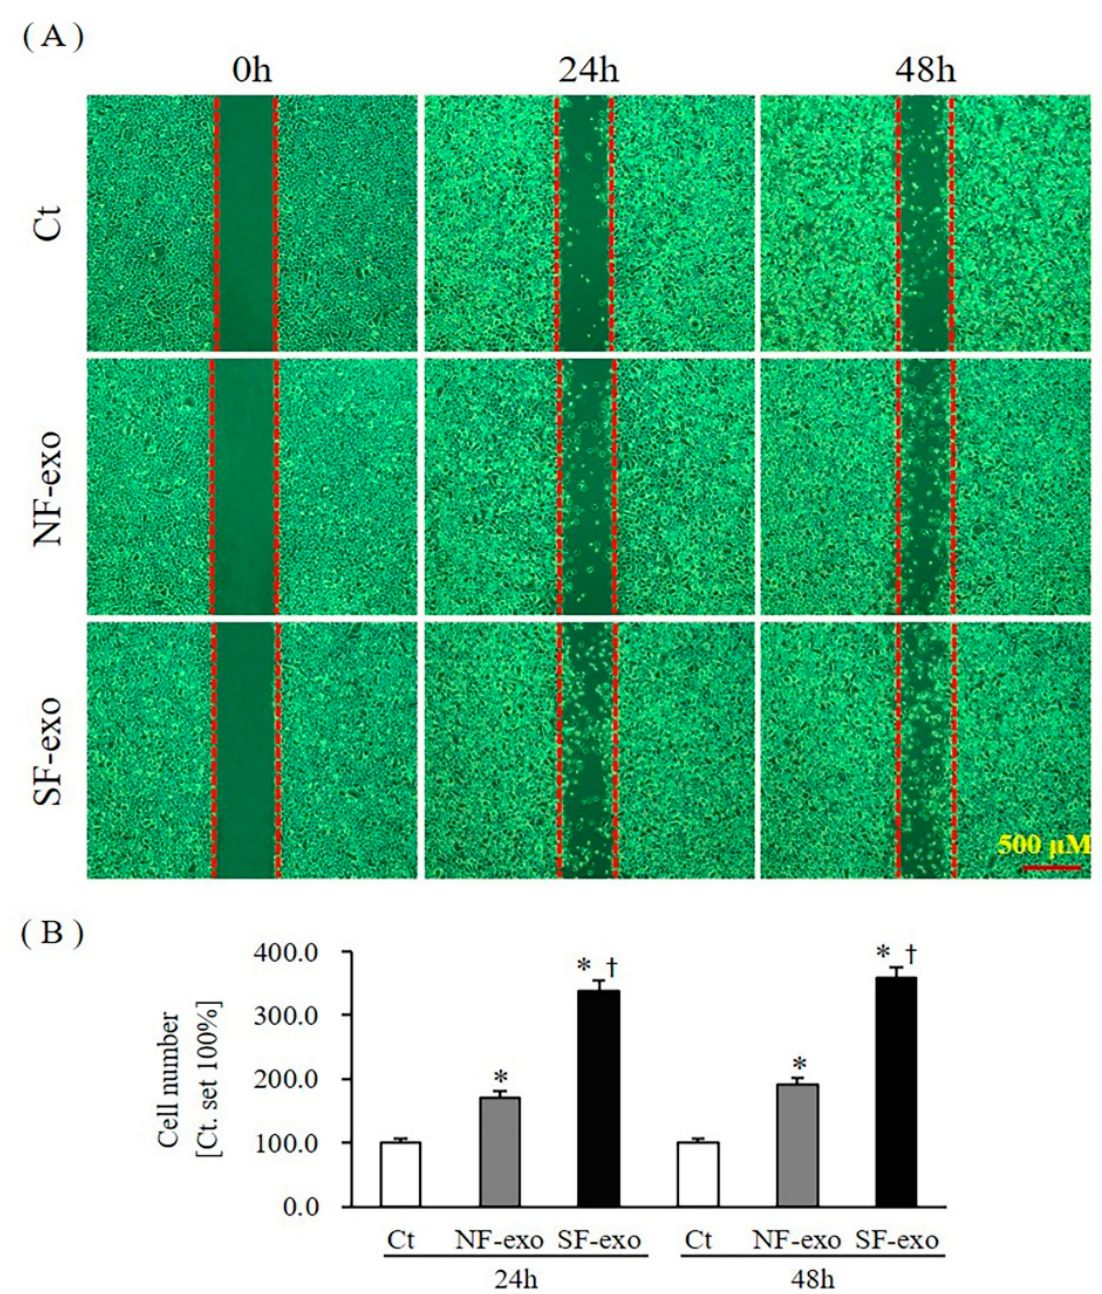
Figure 9. HTSF-exosome treatment dominantly increased the migration of NHKs. NHKs were treated with 100 µg/mL of NF- or HTSF-exosomes, and the control cells were treated with DPBS. After 24 and 48 h, migration of the cells was photographed (scale bar: 500 µm) ( A ). The quantitative analysis of cell migration was expressed as a percentage relative to the control cells ( B ). Ct, DPBS- treated control cells. * p < 0.05 for NF- or HTSF-exosome-treated cells versus the corresponding matched control cells. † p < 0.05 for HTSF-exosome-treated cells versus NF-exosome-treated cells. Data represent the mean ± SD; n = 4. EMT, epithelial–mesenchymal transition; Ct,